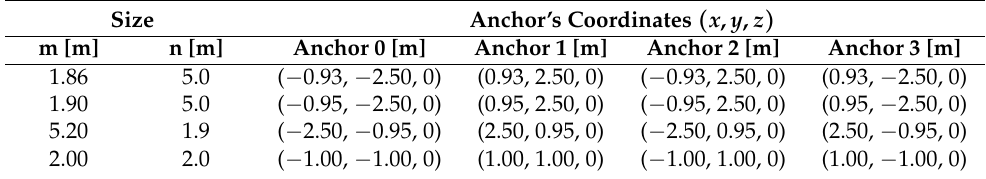
Table 2. Positions of the anchors employed to characterize the positioning